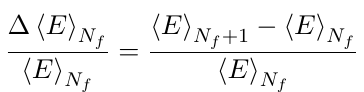
’s for N f = 4 , 8 , as a function of t in units of Λ − 2 i